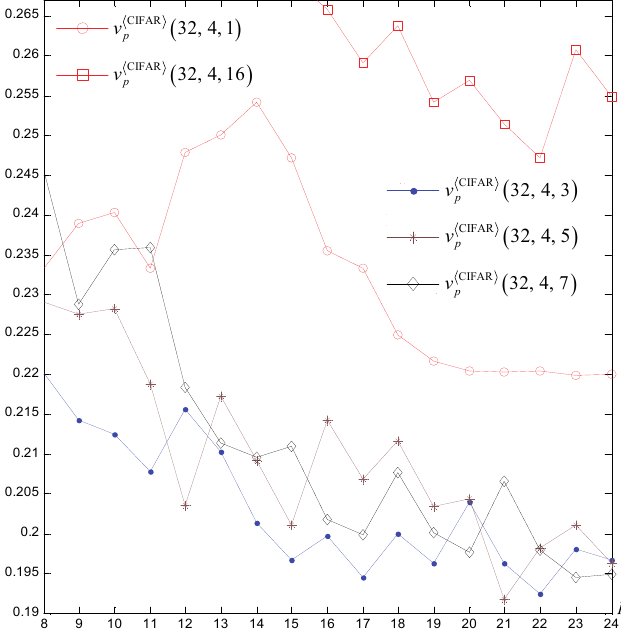
Fig. 19. Error rates against 24 epochs for the CIFAR-10 dataset. Three versions of rational DOL allocation (3, 5, 7) produce similar accuracy, although duration of training is shorter for the rule’s version (a single